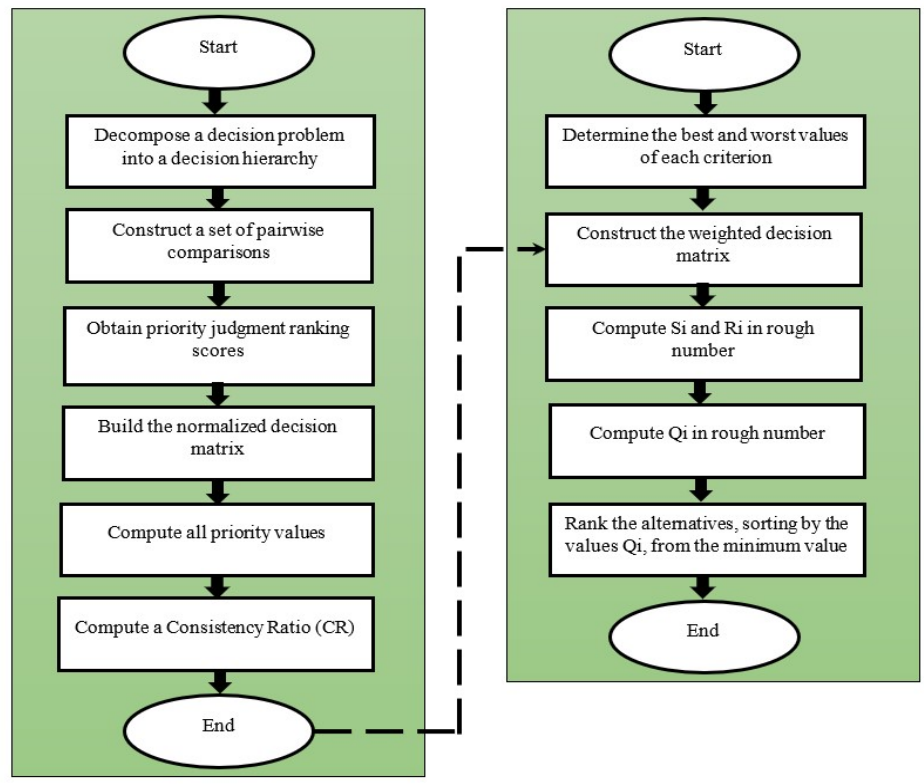
Figure 7. Integrated analytic hierarchy process–vlsekeriterijumskaoptimizacija i kompromisonoresenje (AHP-VIKOR) method for ranking optimal solutions.